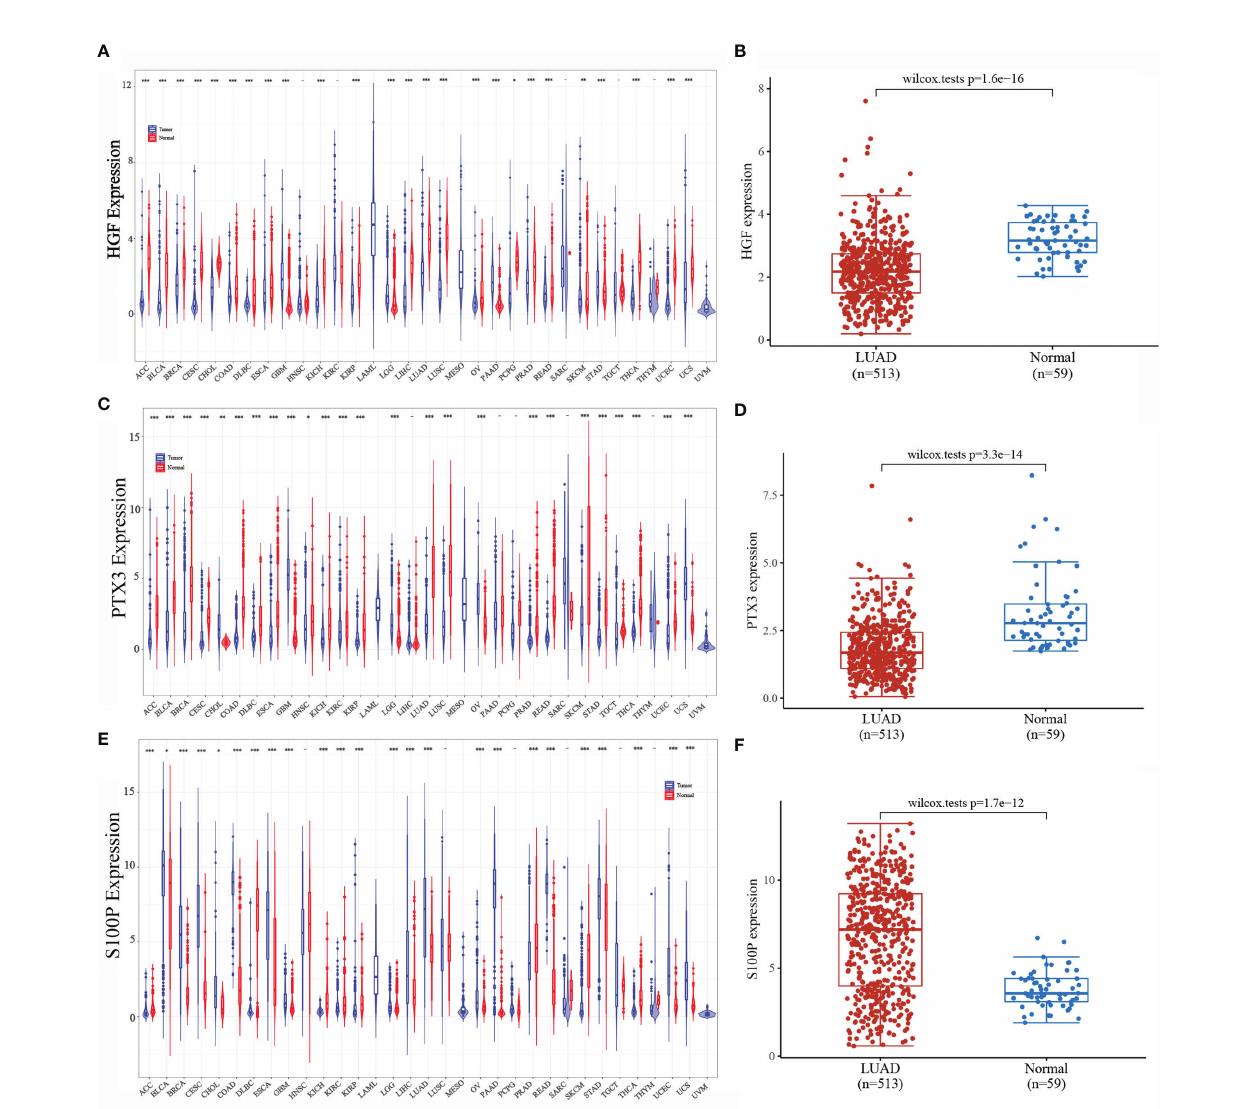
FIGURE 5 | Expression of HGF, PTX3, and S100P. (A) Expression of HGF in pan-cancer; (B) Expression of HGF in LUAD; (C) Expression of PTX3 in pan-cancer; (D) Expression of PTX3 in LUAD; (E) Expression of S100P in pan-cancer; (F) Expression of S100P in LUAD; *P < 0.05, **P < 0.01, ***P <